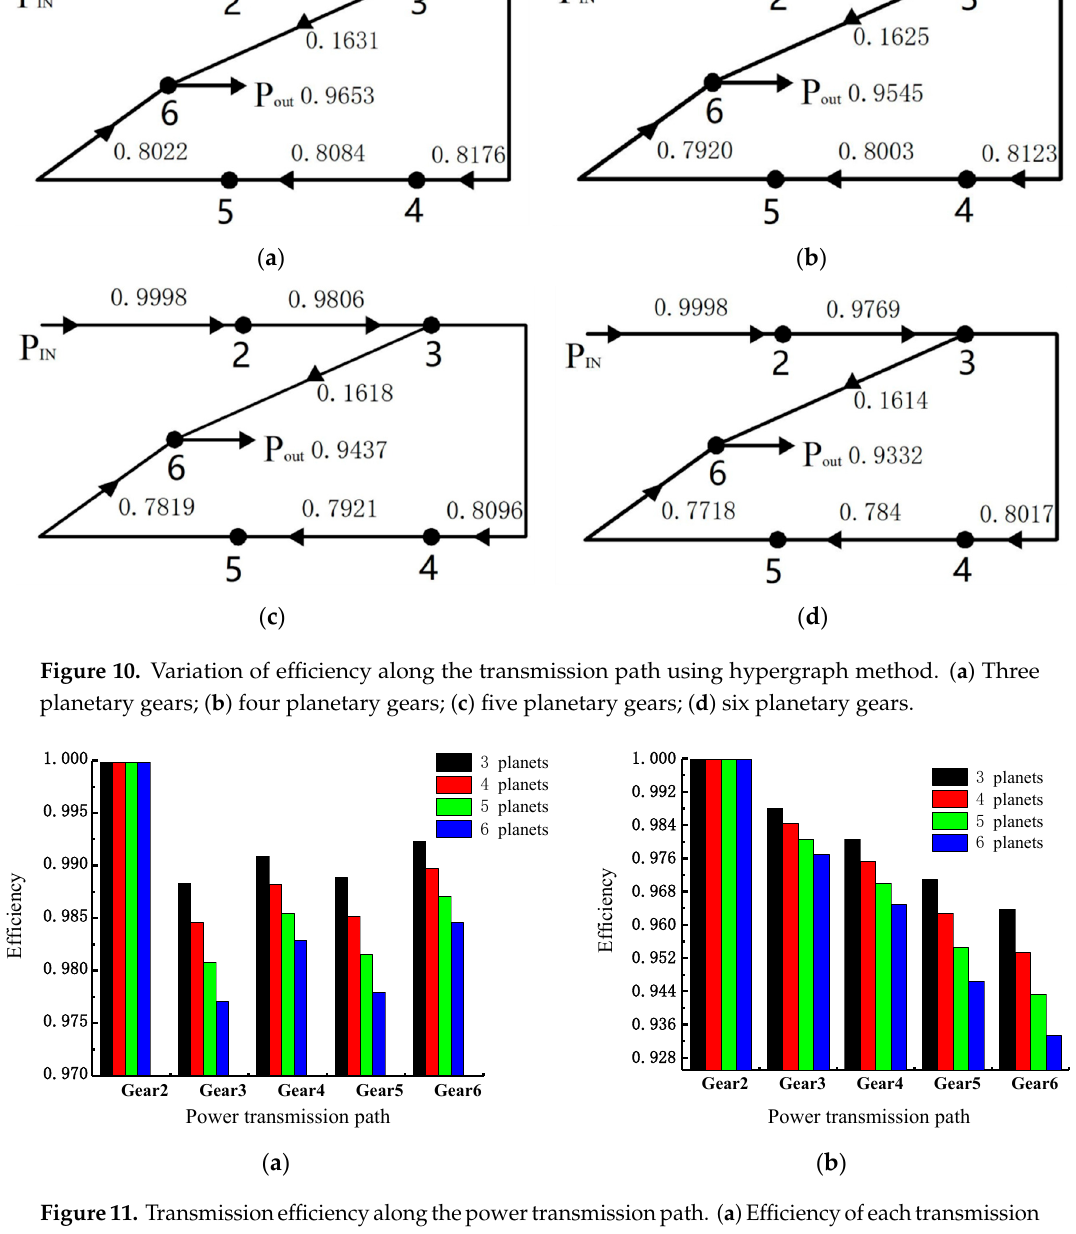
Figure 11. Transmission efficiency along the power transmission path. ( a ) Efficiency of each Figure11. Transmissione ffi ciencyalongthepowertransmissionpath. ( a )E ffi ciencyofeachtransmission transmission element; ( b ) efficiency along the transmission path. element; ( b ) e ffi ciency along the transmission